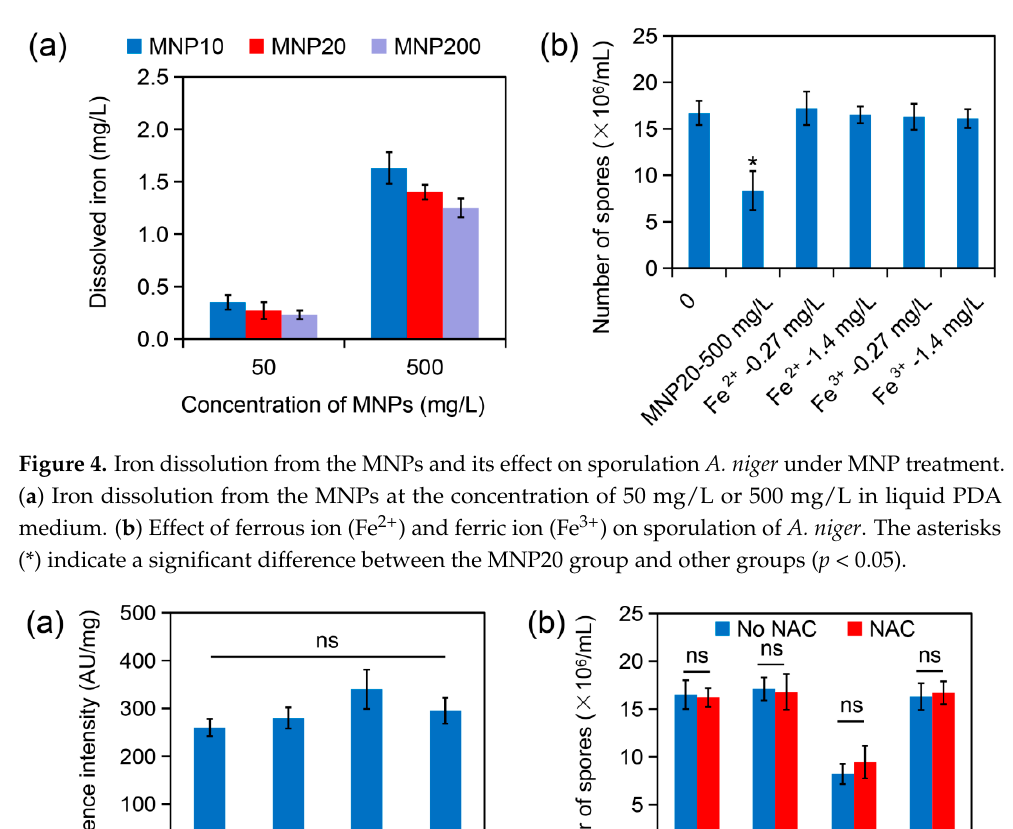
Figure 4. Iron dissolution from the MNPs and its effect on sporulation A. niger under MNP treat- ment. ( a ) Iron dissolution from the MNPs at the concentration of 50 mg/L or 500 mg/L in liquid PDA medium. ( b ) Effect of ferrous ion (Fe 2+ ) and ferric ion (Fe 3+ ) on sporulation of A. niger . The asterisks (*) indicate a significant difference between the MNP20 group and other groups ( p < 0.05).